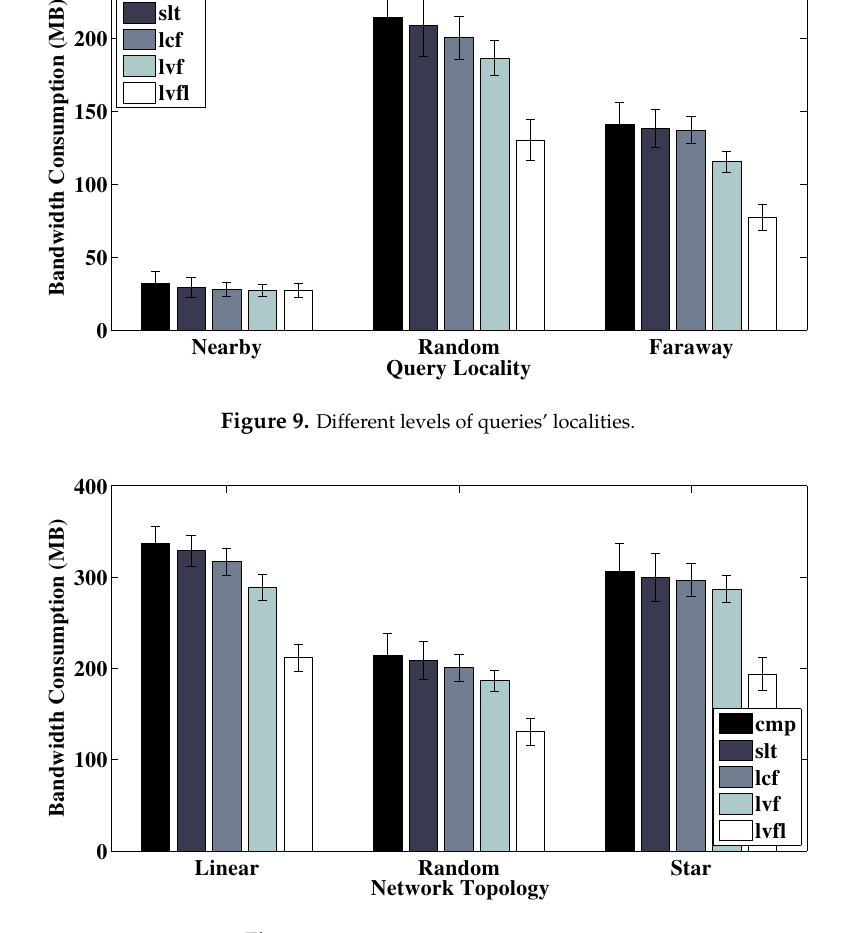
Figure 10. Different network